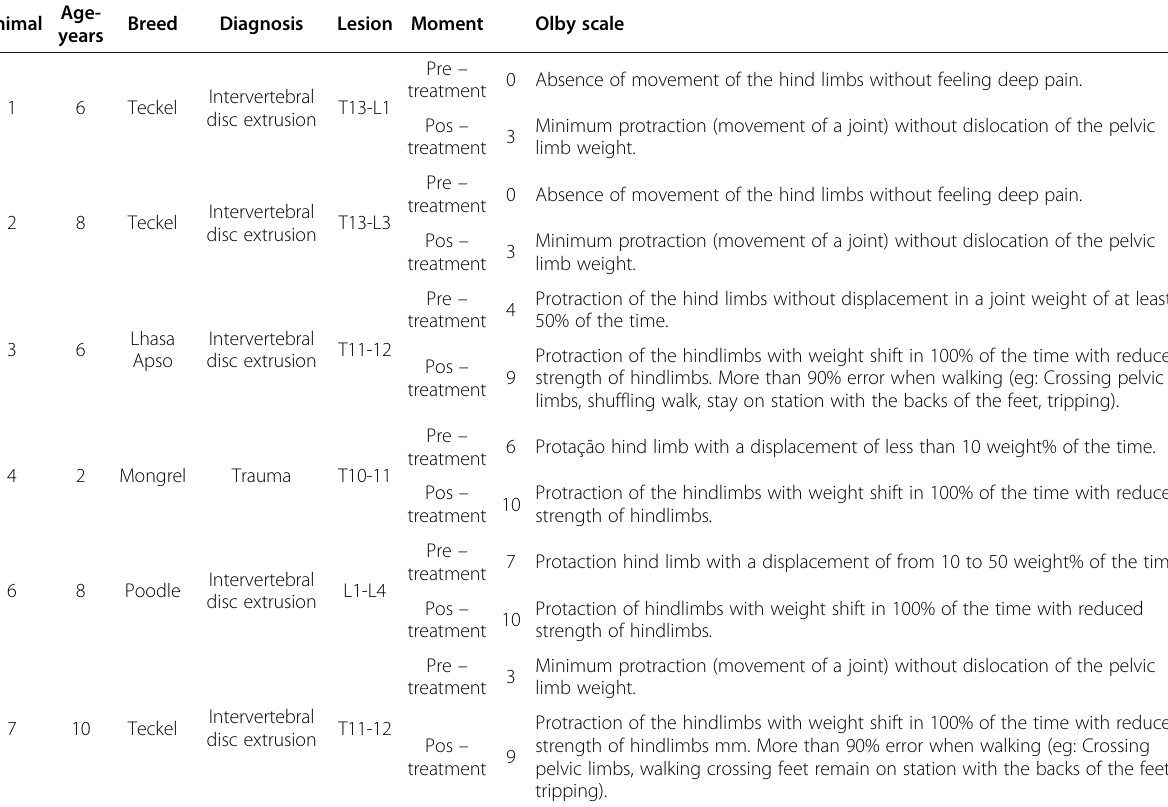
Table 1 Group of animals showing height of the lesion by MRI and data relating to assessments of physical therapy animals, according to Olby scale before and after the surgical procedure and injection of stem cells Age- Animal Breed years